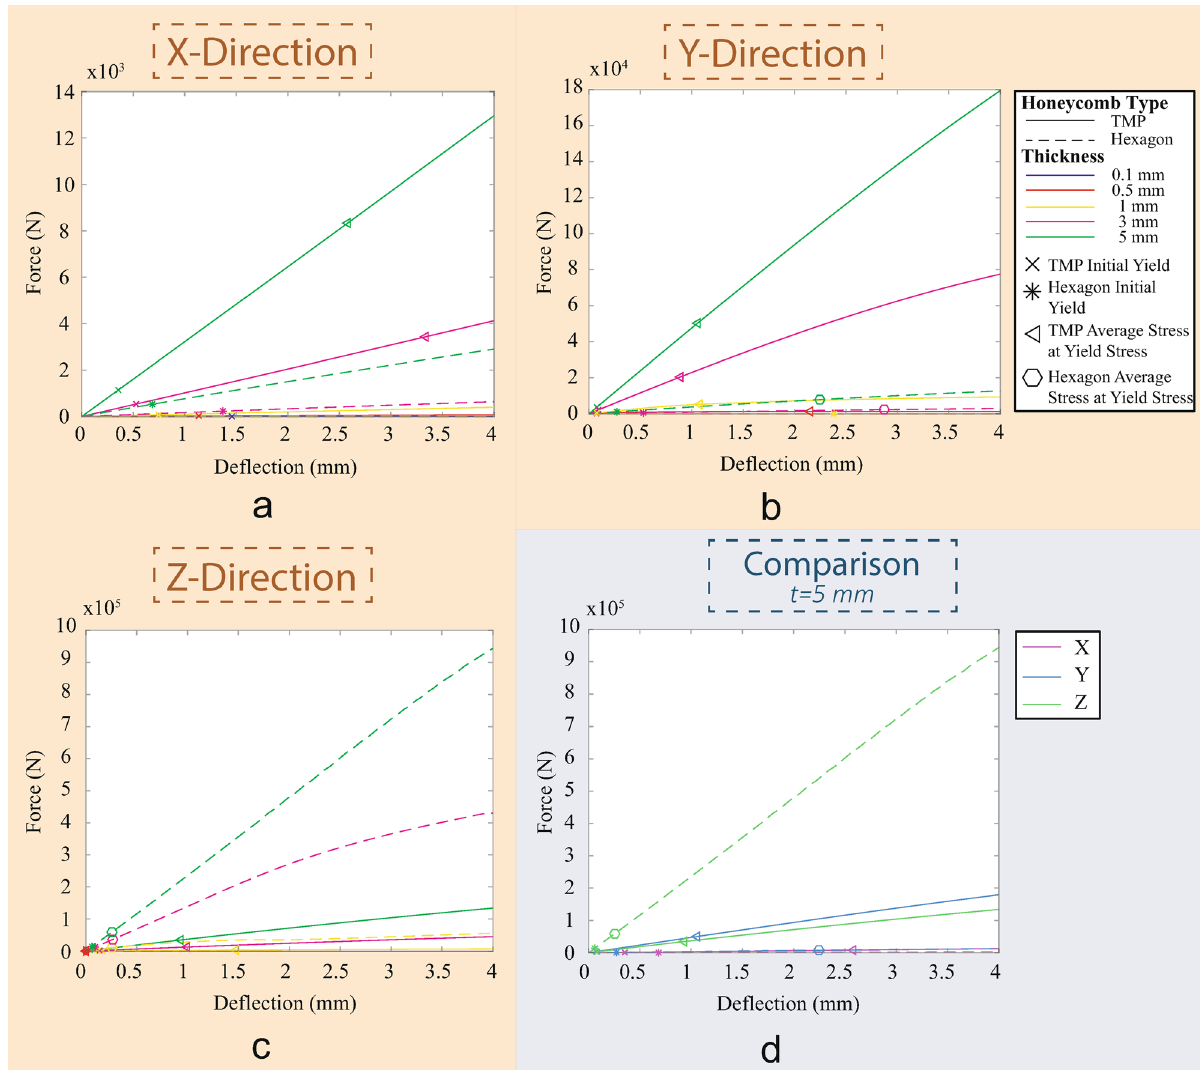
Figure 7. Force-deflection trends for the Tachi–Miura Polyhedron and Hexagonal Honeycombs with Aramid material properties in the x , y , and z directions for the different material thicknesses. ( a ) The x -direction force- deflection curves. ( b ) The y -direction force-deflection curves. ( c ) The z -direction force-deflection curves. ( d ) A comparison of the 5 mm thick TMP and Hexagonal honeycombs’ force-deflection responses in the x , y , and z -directions. The solid lines represent the TMP force-deflection behavior and the dashed lines represent the Hexagonal honeycomb force-deflection behavior. The ‘ ’ shows the initial yield point for the TMP. The ‘ ’ shows × ∗ the initial yield point for the hexagonal honeycomb. The hexagon shape shows the location where the average stress is at the yield stress for the TMP honeycomb. The triangle shape (‘ ’) shows the location where the average ⊲ stress is at the yield stress for the Hexagonal